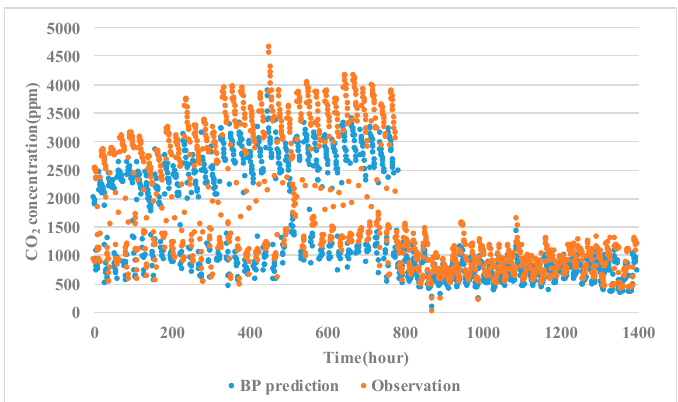
Figure 5. Scatter plot of BP model. Note: The data on the left are autumn and winter, the data on the right are spring and summer.